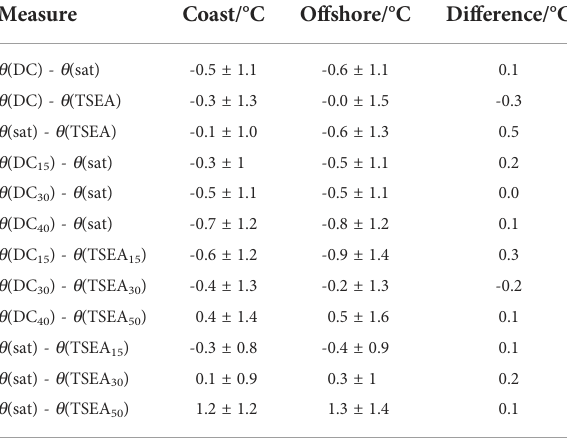
TABLE 3 Mean bias by depth level and coastal grouping.